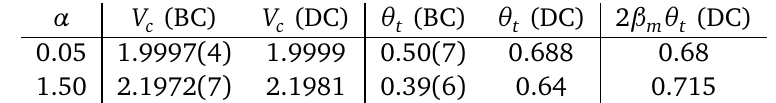
Values of V , θ , and β (see text) associated to the ground state c t m paramagnetic-ferromagnetic transition, computed via FSS analysis of the Binder cu- mulant crossings (BC) and via data collapse of the squared magnetization m 2